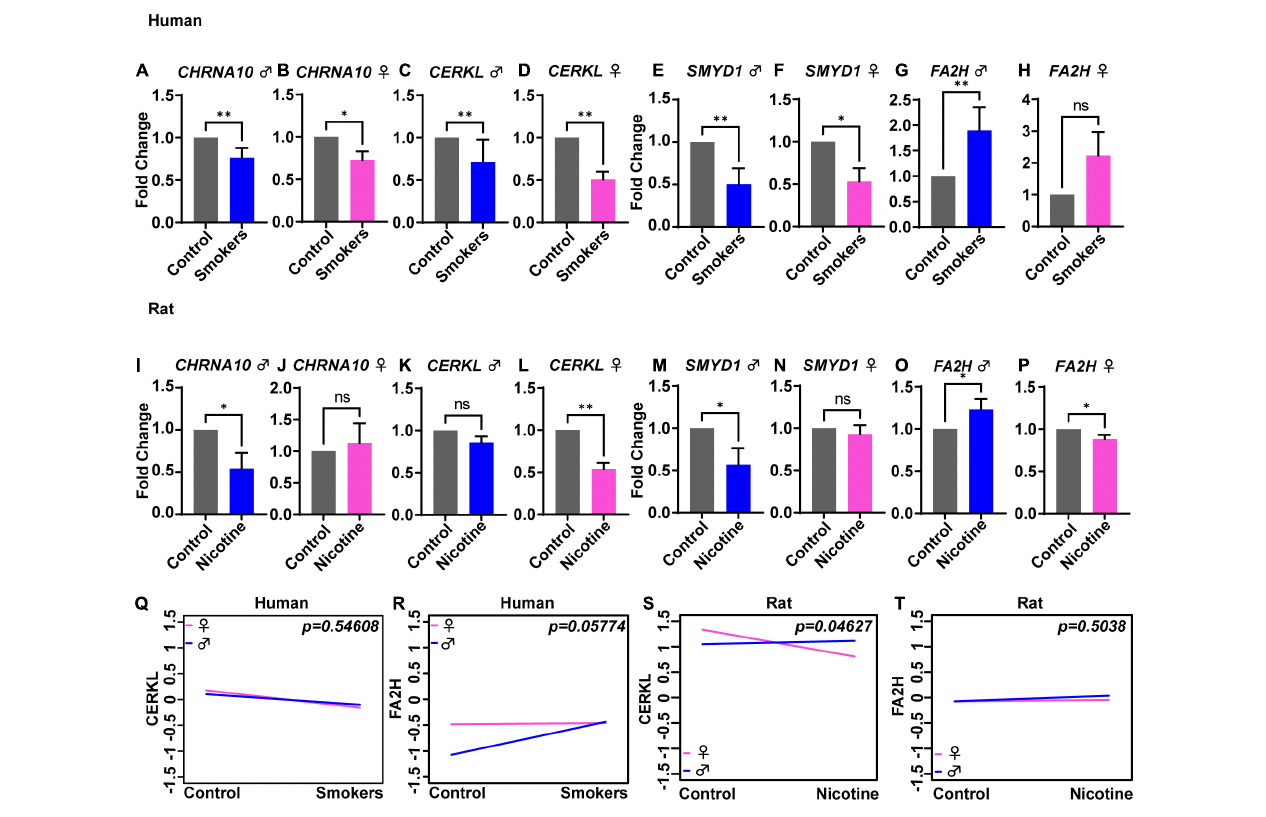
FIGURE2 Sex-dependent changes in gene expression levels in human smokers and rats treated with nicotine. Gene expression expressed in fold change was analyzed in males (blue) and females (pink) for humans (A–H) and rats (I–P) . ANCOVA analysis showed no significant differences between human males and females for the following genes: CERKL (Q) and FA2H (R) . In rats, ANCOVA analysis showed significant differences between male and female rats for gene CERKL (S) , but not for FA2H (T) . Each bar represents the mean ± SEM of six humans or rats; ns, no significant; ∗ p < 0.05; ∗∗ p < 0.01 ( t -test).